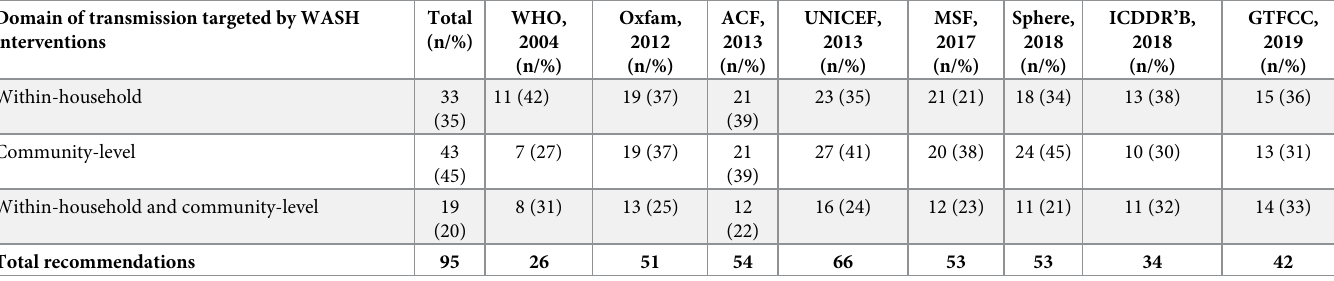
Table 6. Categorisation of WASH recommendations, by each of the eight included guidelines, according to domains of cholera transmission. Domain of transmission targeted by WASH